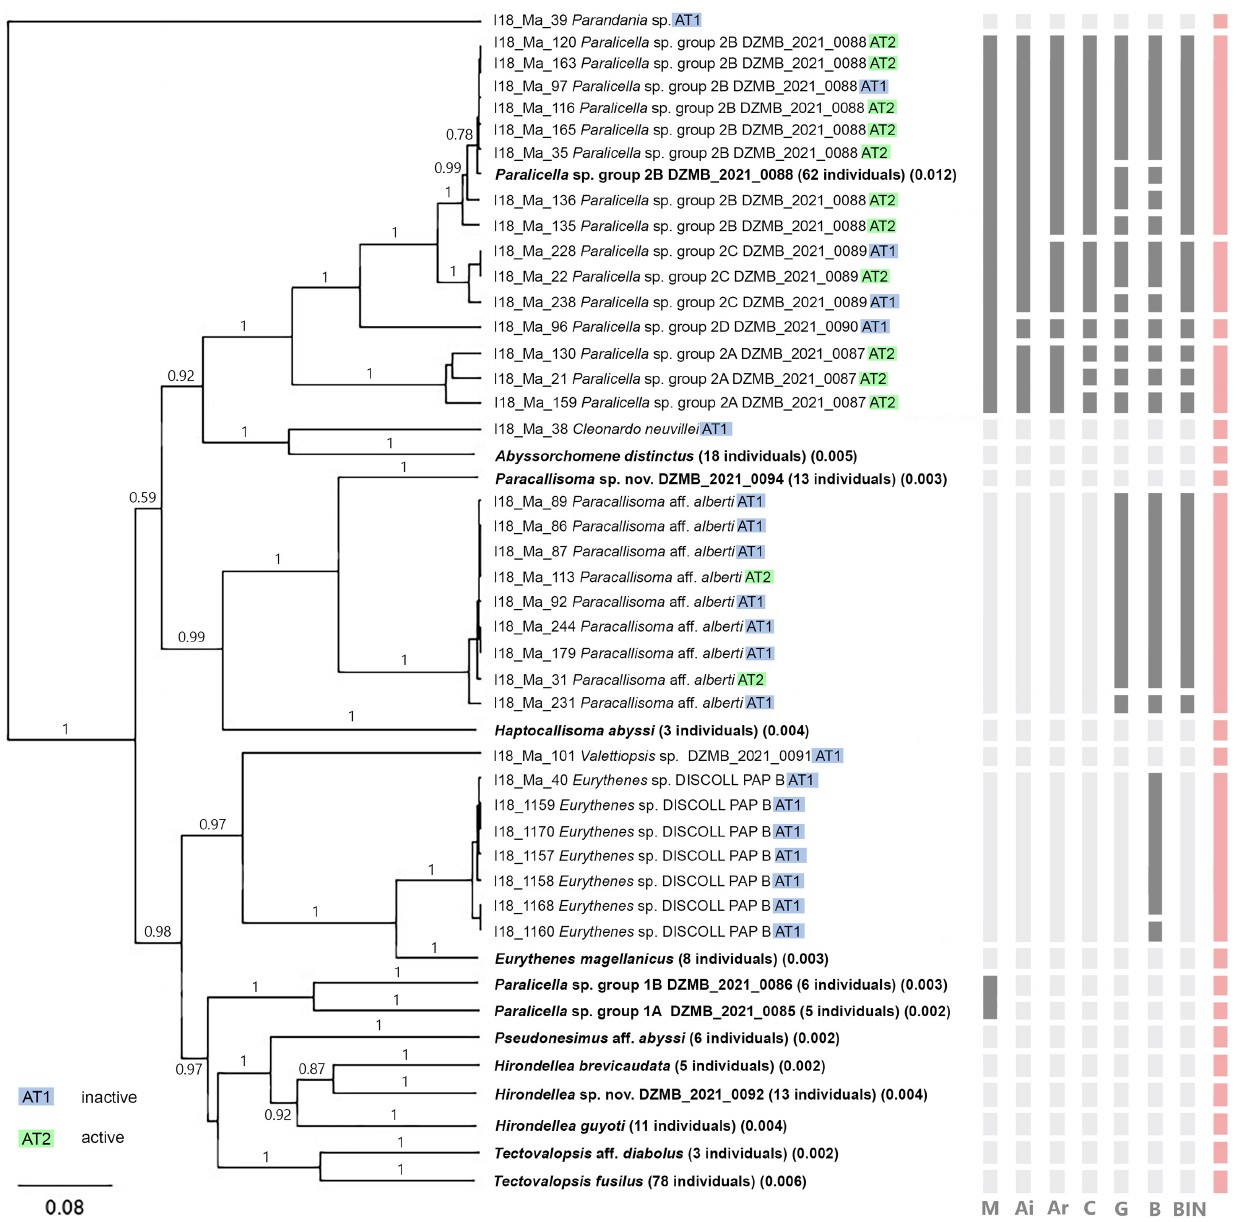
stomach of a fish off Cape Horn (Stoddart and Lowry,